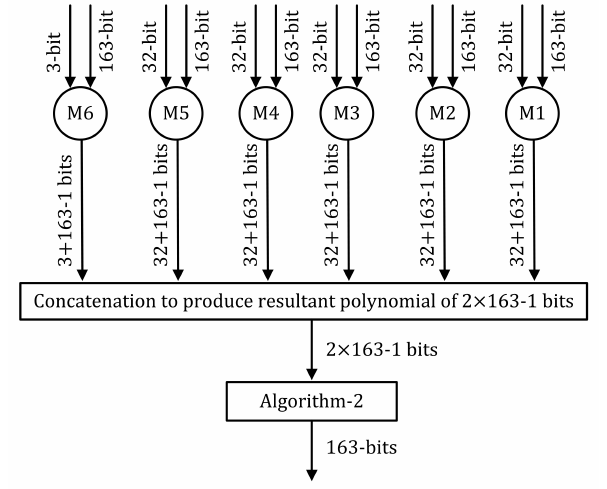
Figure 2. Digit-parallel multiplier over GF ( 2 163 ) .